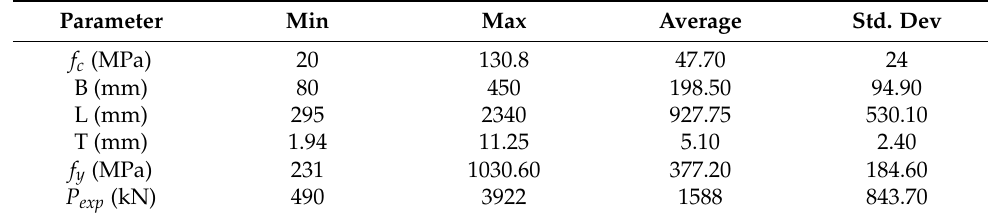
Table 2. Statistical distribution of data used in the modeling.